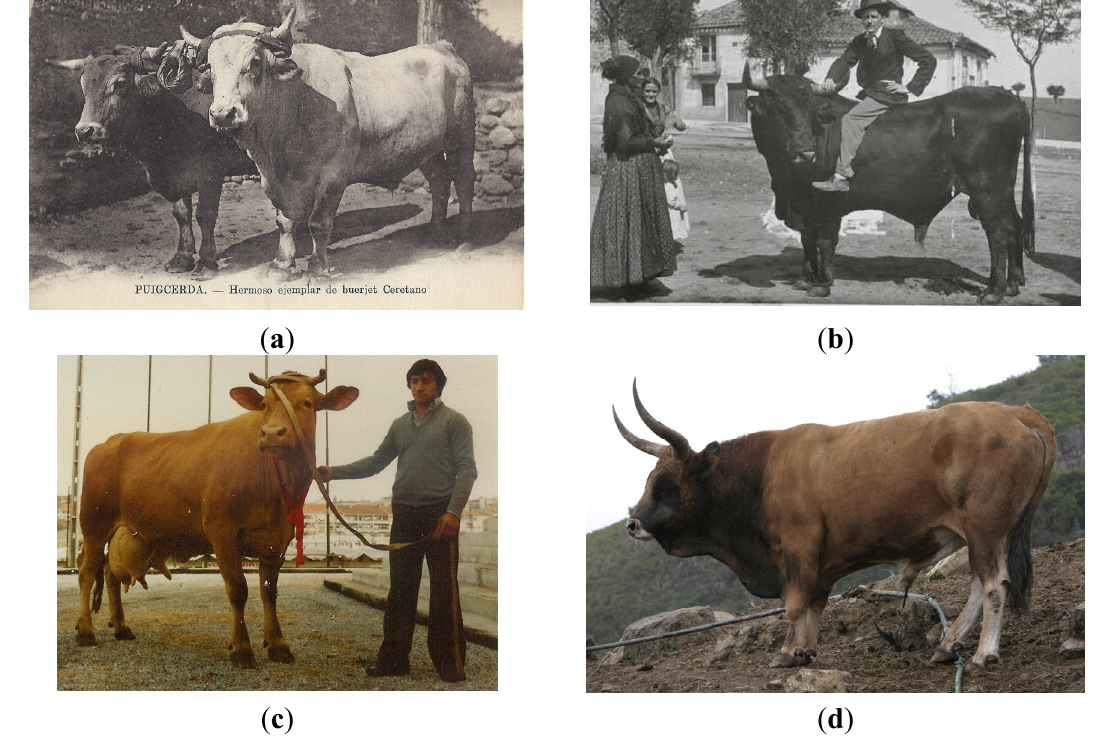
Figure 17. Iberian cattle. ( a ) Pyrenean ox team from Puigcerda, N.W. Spain, 1920s postcard; ( b ) Serrana Negra or Negra Iberica bull; Spain ( c ) Minhota cow, Portugal 1960s; and ( d ) Barrosã bull, 2006 (c,d: photographs by Marleen